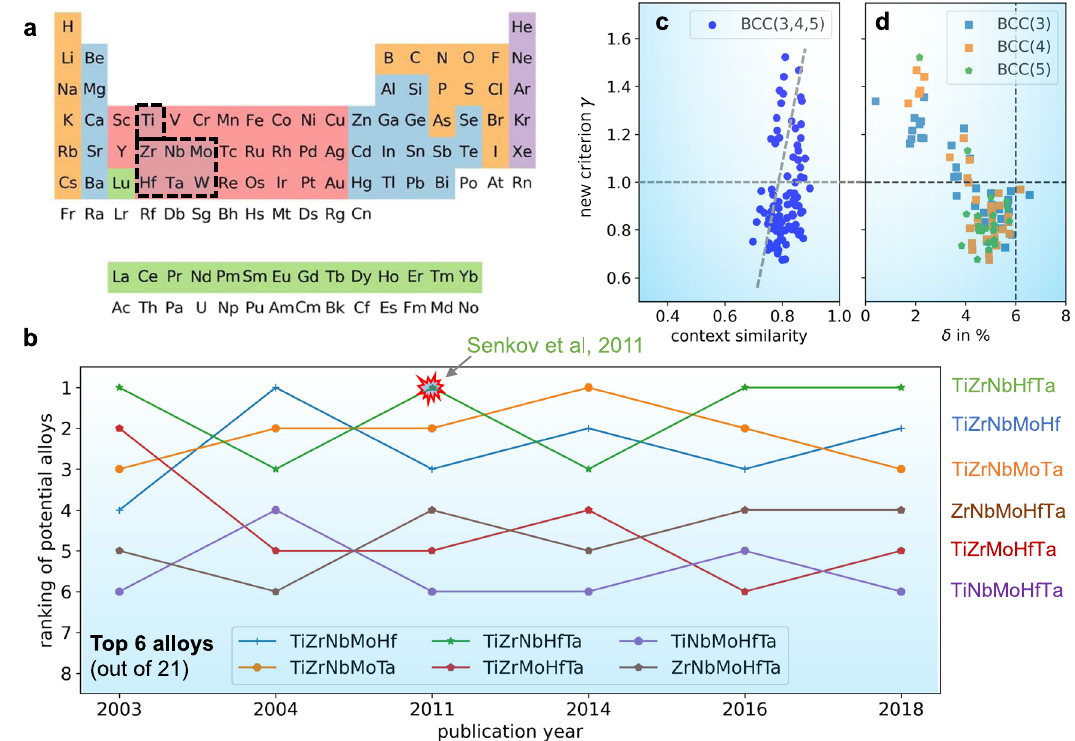
Fig. 3 | The context-similar elements and their applications for BCC high- entropy alloys. a Taking the transition elements (Ti, Zr, Nb, Mo, Hf, Ta, and W) as anexample, we showthatthe tendencyto formsolidsolutions is correlated to the newly de fi ned context similarity. For better visualization, we only consider here three-, four-, and fi ve-component equiatomic alloys. b The fi ve-component alloys are ranked bytheir contextsimilarity for different publicationyears. The top three